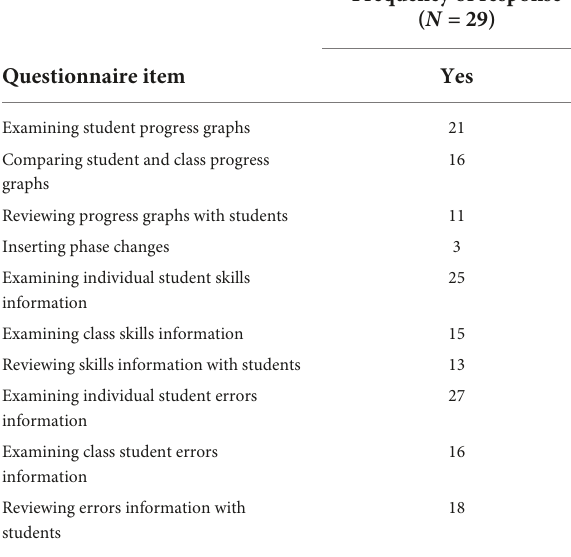
TABLE 11 Teacher reports of task engagement with data management